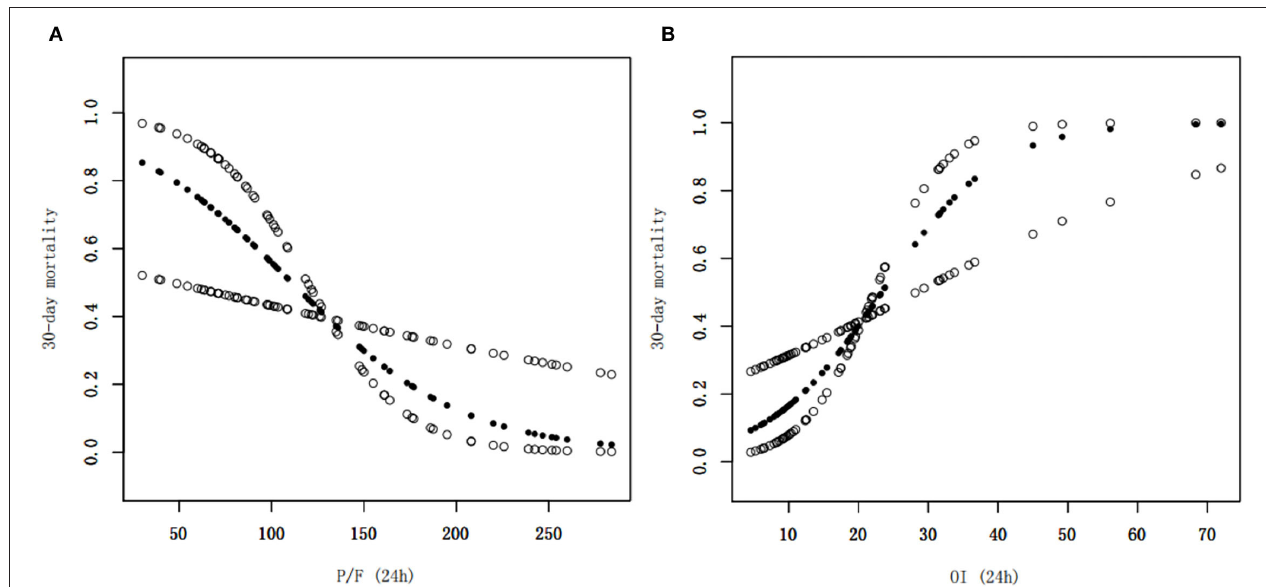
FIGURE 2 | Smoothed regression curves showed that a low P/F ratio and a high OI at 24h were associated with a higher 30-day mortality risk. The model is adjusted for sex, age, septicemia, MAP (0h), PIP (24h), and Lac (24h), CRRT, and number of extrapulmonary organ failure ( ≥ 2). P/F, PaO 2 /FiO 2 ; OI, oxygenation index, MAP,